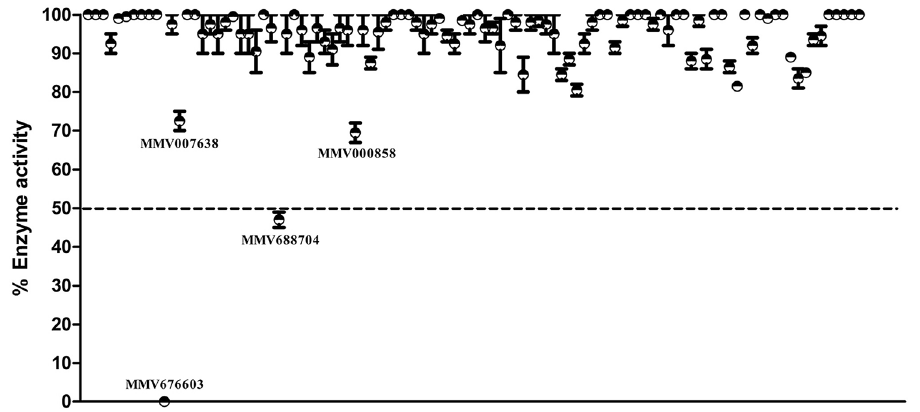
Figure 3. In-vitro screening of best hundred hits against PfUCHL3 activity: a scatter plot representing percent enzyme activity inhibition of fifty promising Pathogen Box compounds, identified from computational evaluation at 100 μM concentration. The dashed line at 50 is considered as inhibitory cutoff. Compounds with more than 50% inhibition threshold were considered for further screening. Bar denotes the standard deviation (n = 3) for each compound.